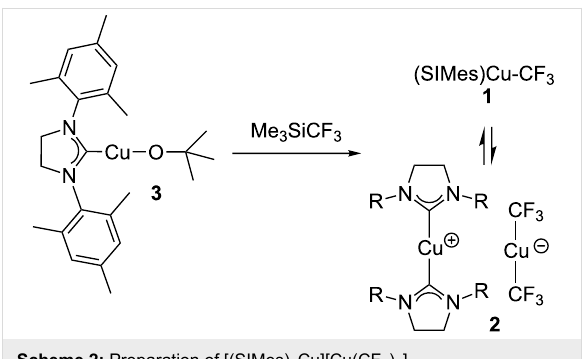
activity for the trifluoromethylation of aryl halides [10,11].